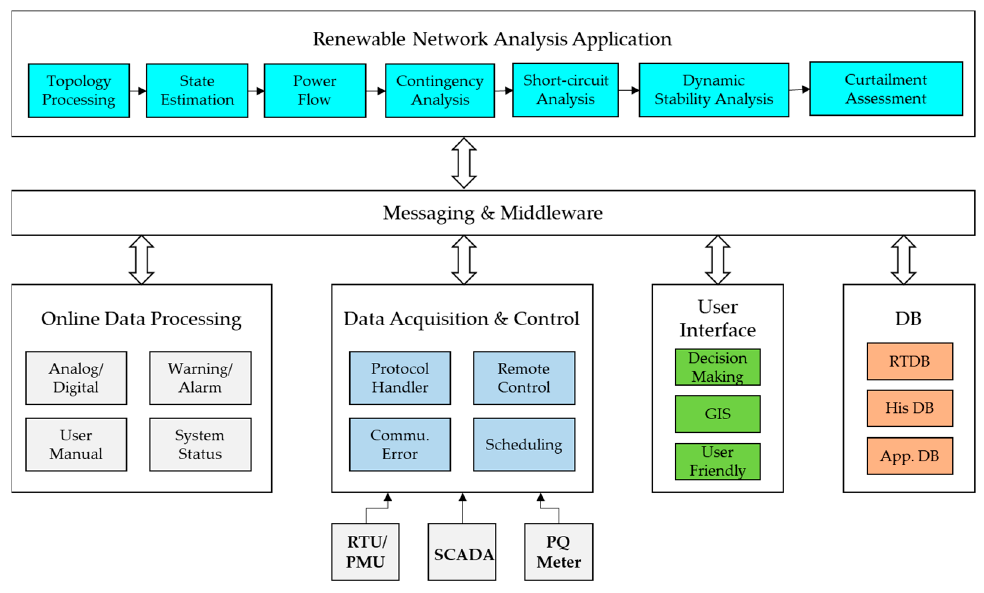
Figure 1. Application structure of REMS.